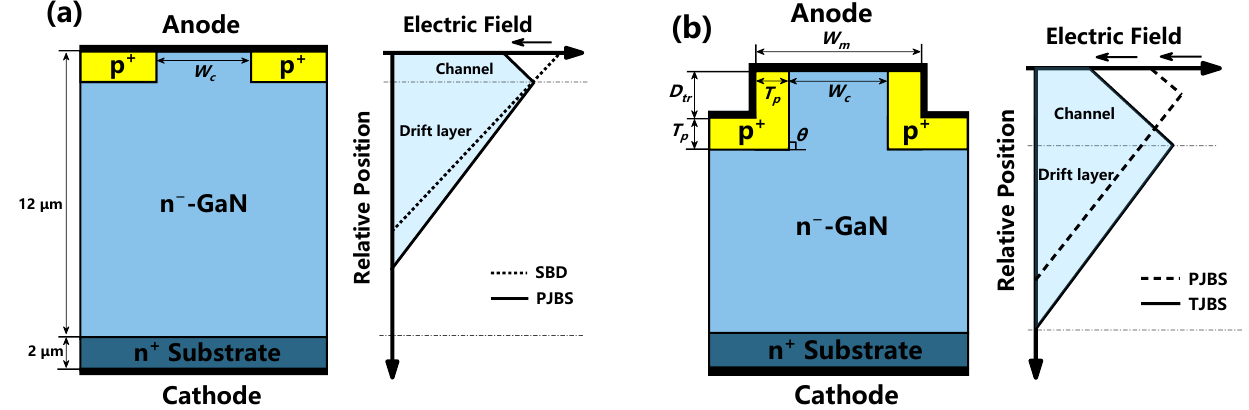
Figure 1. Cross-sectional schematic diagram and electric field distribution along the channel midline of: ( a ) the conventional PJBS diodes; and ( b ) the TJBS diodes. The reverse blocking capability of TJBS diodes is dominated by the electric field